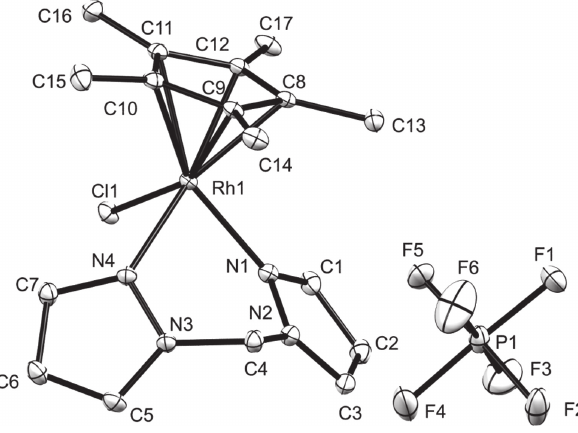
Table 2: Fractional atomic coordinates and isotropic or equivalent isotropic displacement parameters (Å 2